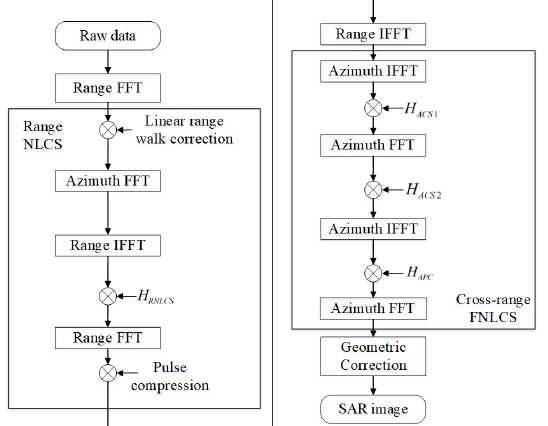
Figure 4. Flowchart of the proposed